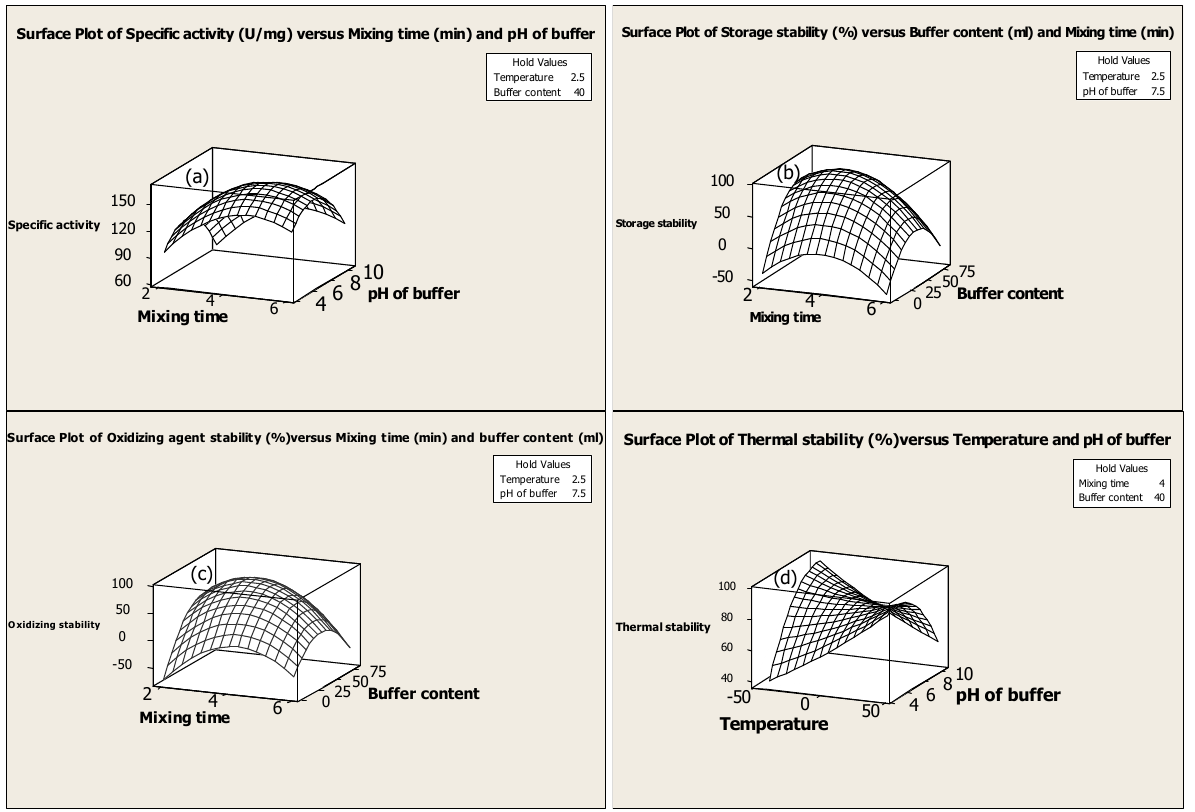
Figure 1. Response surface plots showing the interaction effects of (a) specific activity (b) storage stability and (c) oxidizing agent stability (d) Thermal